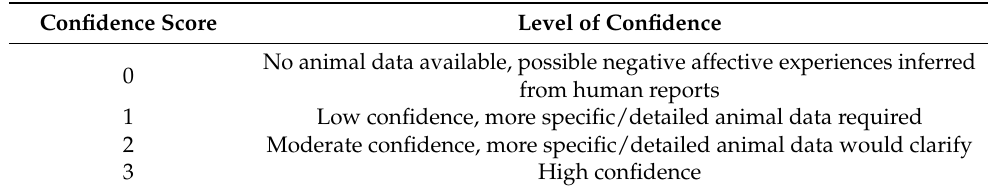
Table 4. Confidence scores to accompany Impact and Duration Scores